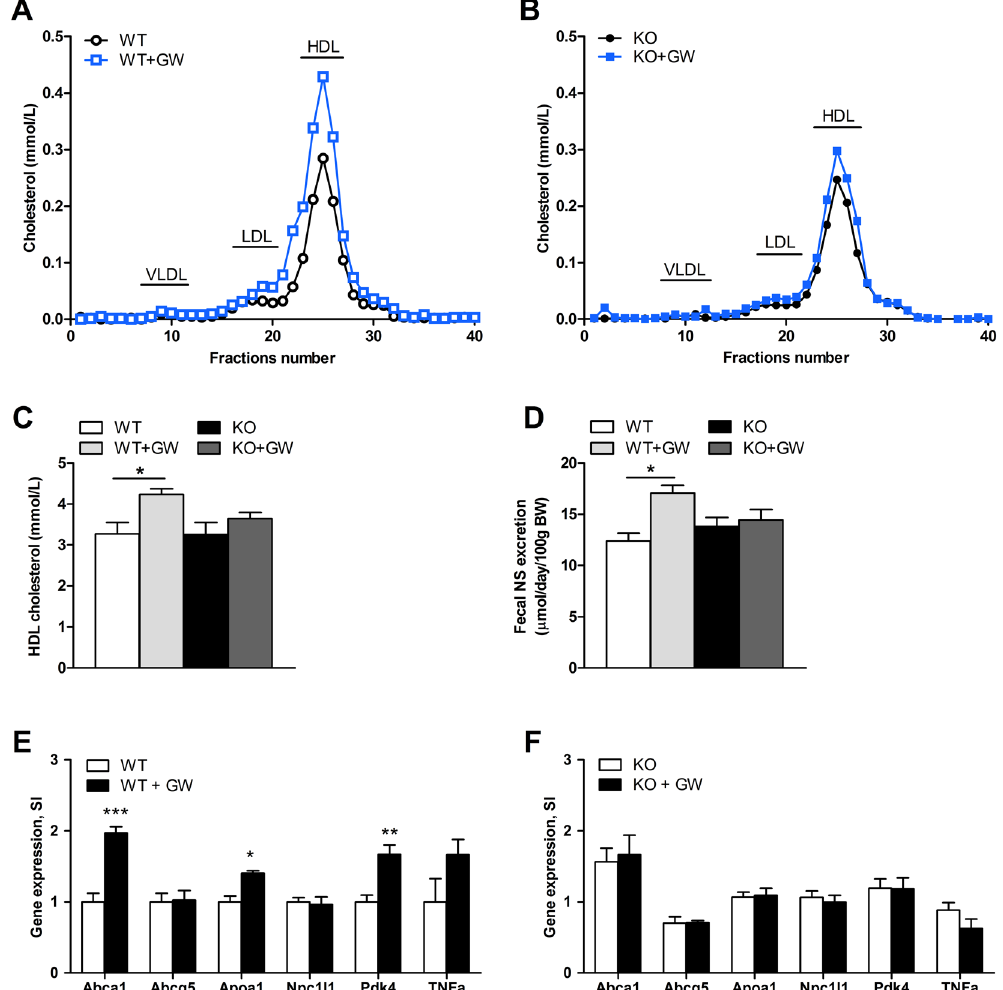
Figure 4. Effect of PPAR δ activation on cholesterol metabolism and intestinal gene expression in PPAR δ IEC-KO and wild-type mice. ( A , B ) FPLC Lipoprotein cholesterol profiles of pooled plasma samples from ( A ) wild-type and ( B ) PPAR δ IEC-KO mice treated with for 14 days with GW501516 or vehicle (n = 7). Plasma levels of ( C ) HDLc; and ( D ) Fecal neutral sterol (NS) excretion in wild-type and PPAR δ IEC-KO mice (n = 7) treated for 14 days with GW501516 (GW) or vehicle; ( E , F ) Levels of mRNA (normalized to 36b4) of genes involved in lipoprotein metabolism and inflammation in the mucosa of the small intestine of ( F ) wild-type and ( G ) PPAR δ IEC-KO mice treated for 14 days with GW501516 or vehicle (n =